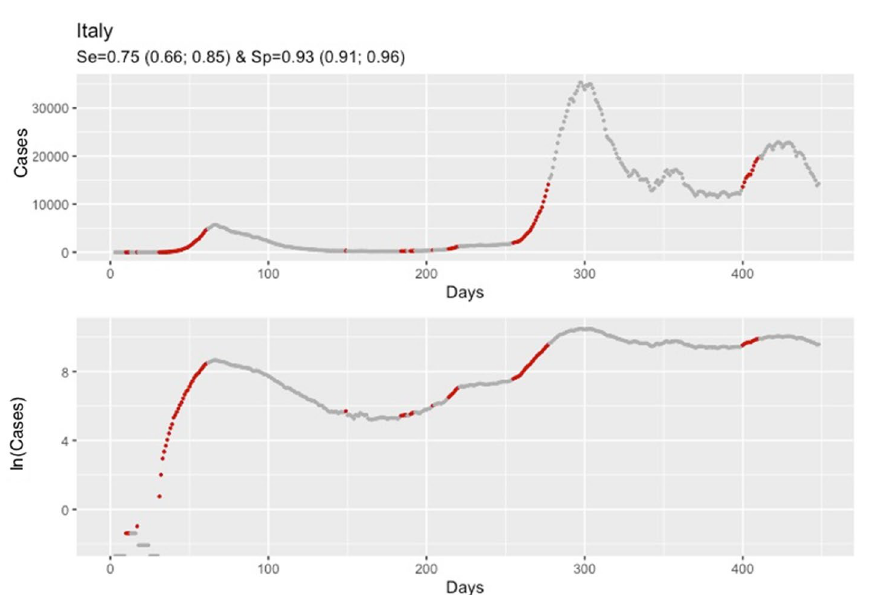
Figure 7. Daily confirmed cases of COVID-19 in Italy, from January 22, 2020, until April 13, 2021. Analysis is based on the criterion aiming to detect an increase in the mean of expected cases equal or higher than 50%. Red dots correspond to dates that, based on EVI, an early warning was issued indicating that a rise in the COVID-19 cases is expected. Data are presented on the original scale ( 1a ) and the logarithmic scale ( 1b ) which facilitates the comparison of the steepness of the epidemic curve between the different